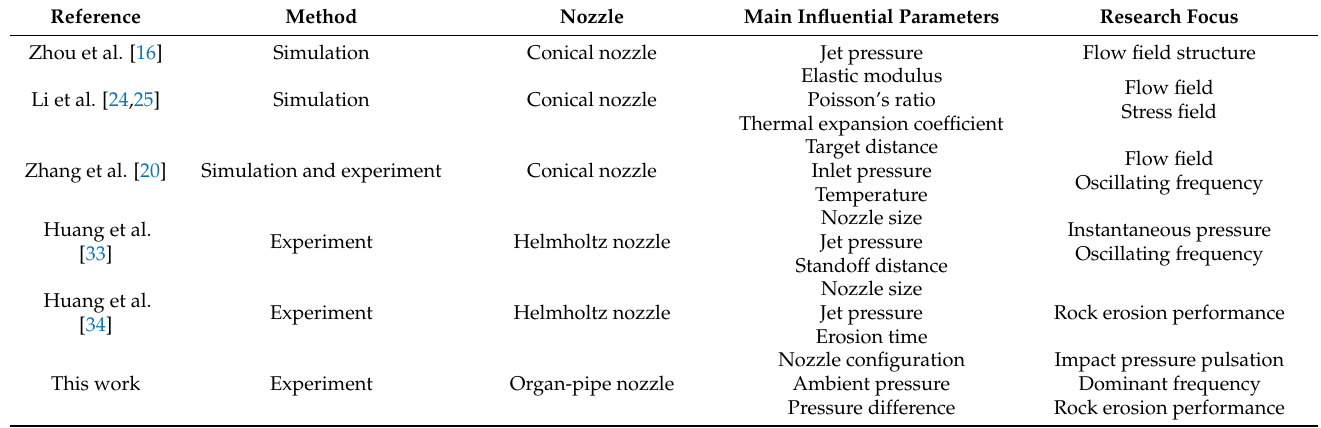
Table 1. Comparison between previous studies on SCO 2 jets and this